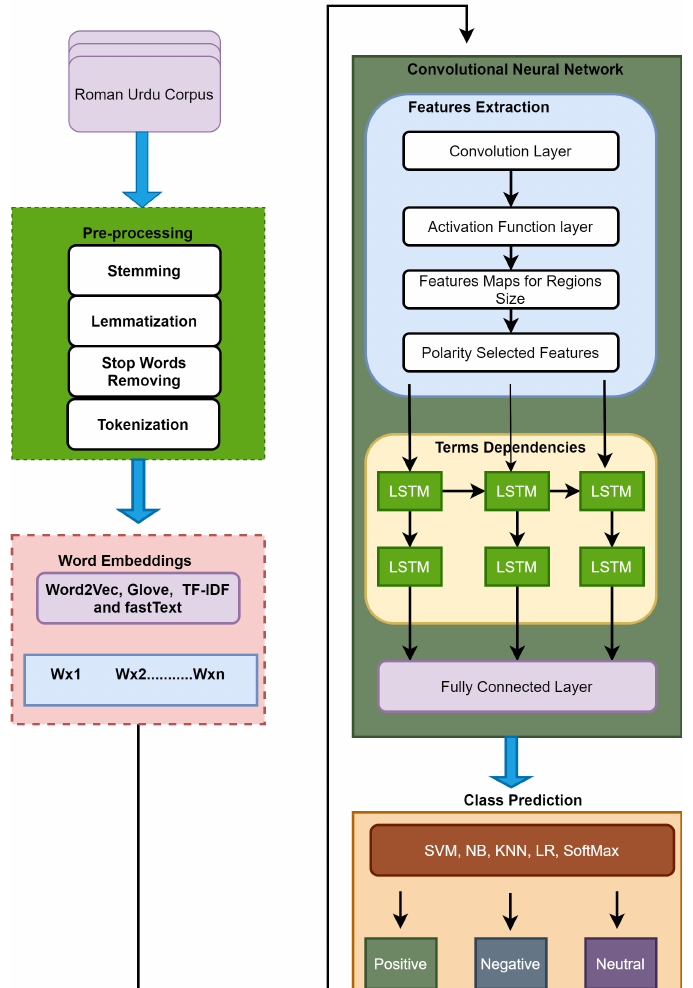
Figure 2. Abstract-level architecture of proposed CNN-LSTM Roman Urdu sentiment analysis.